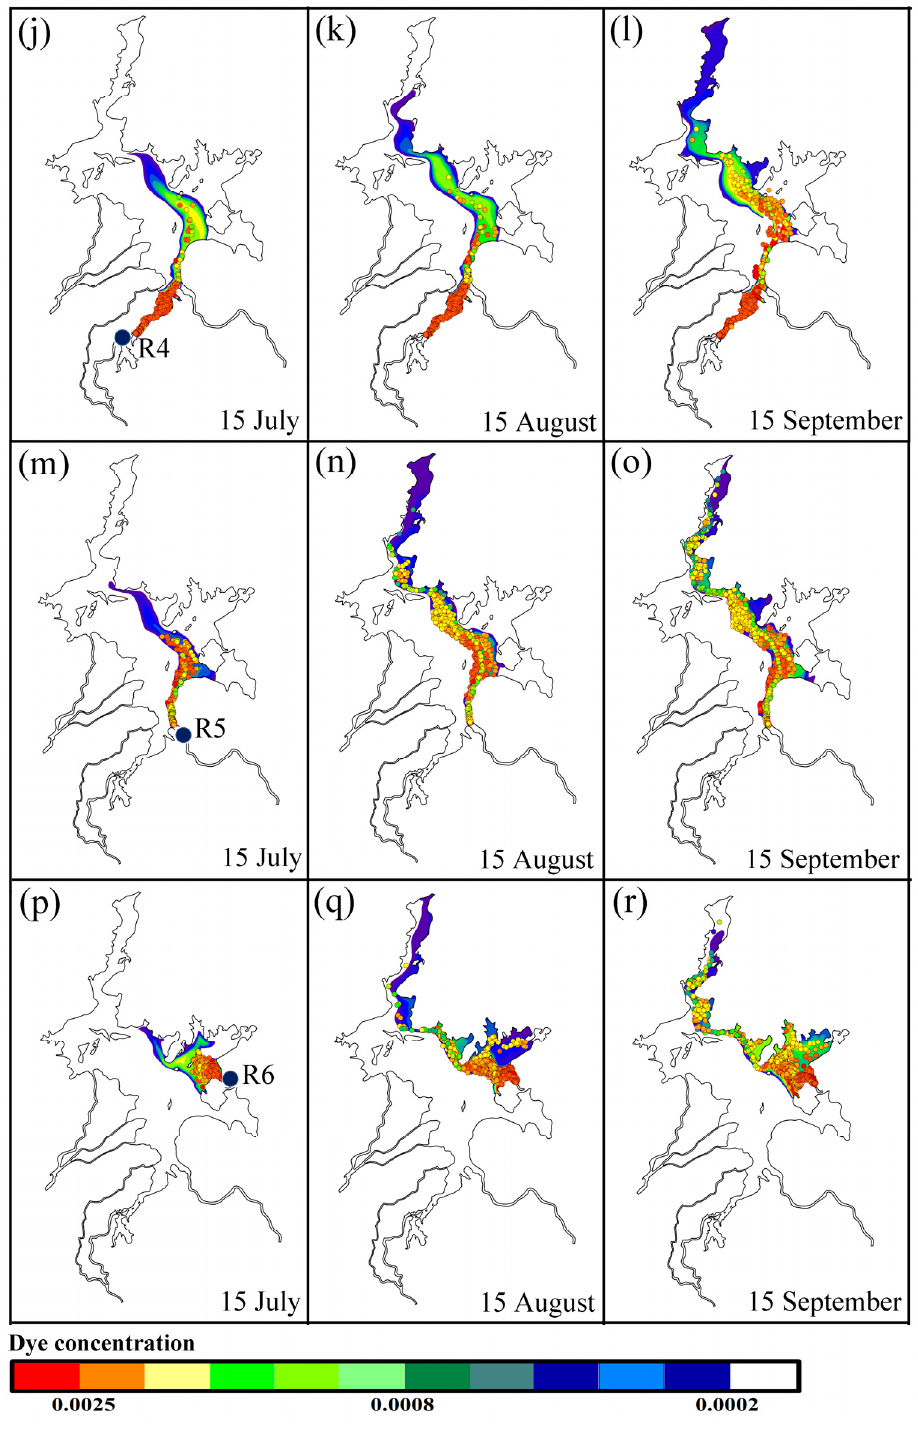
Figure 4. Spatial distribution of dye concentration (in kg/m 3 ) and particle trajectories (colored dots) at selected time slices during July–September. ( a – c ) represents the releases at river mouth of the northern branch of the Ganjiang River (marked by R1); ( d – f ) represents the releases at river mouth of the middle branch of the Ganjiang River (R2); ( g – i ) represents the releases at river mouth of the southern branch of the Ganjiang River (R3); ( j – l ) represents the releases at river mouth of the eastern branch of the Fuhe River (R4); ( m – o ) represents the releases at river mouth of the Xinjiang River (R5); and ( p – r ) represents the releases at river mouth of the Raohe River